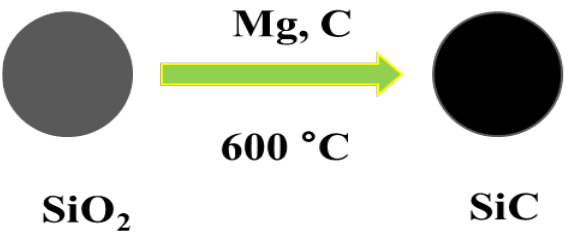
Figure 2. Schematic representation showing the synthesis process of SiC NPs.